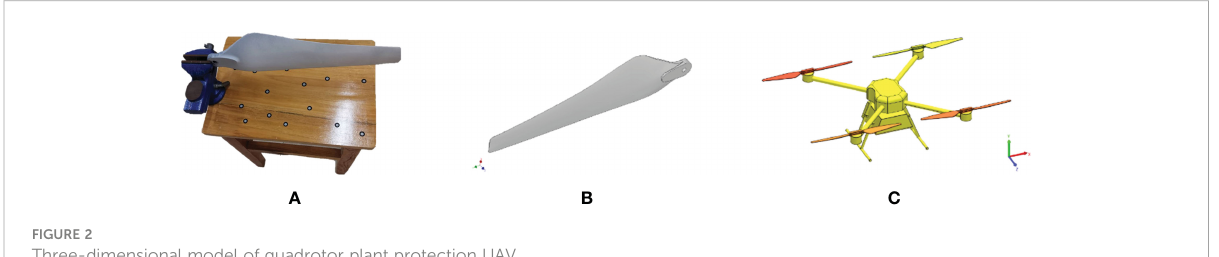
FIGURE 2 Three-dimensional model of quadrotor plant protection UAV.